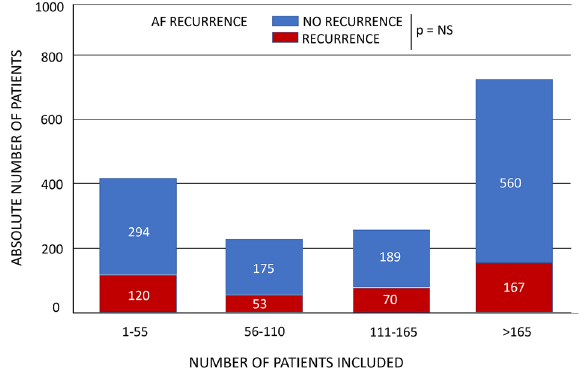
Figure 5. AF recurrence and no-recurrence at 12-months of follow-up (absolute number of patients) by center experience. Centers were divided into four quartiles of expertise with a fixed range of 55 patients in each quartile, increasing in the level of experience. There was not statistical difference regarding either overall recurrence at 12-month follow-up or the rate of adverse events. Procedure characteristics were different between quartiles (Table S2).